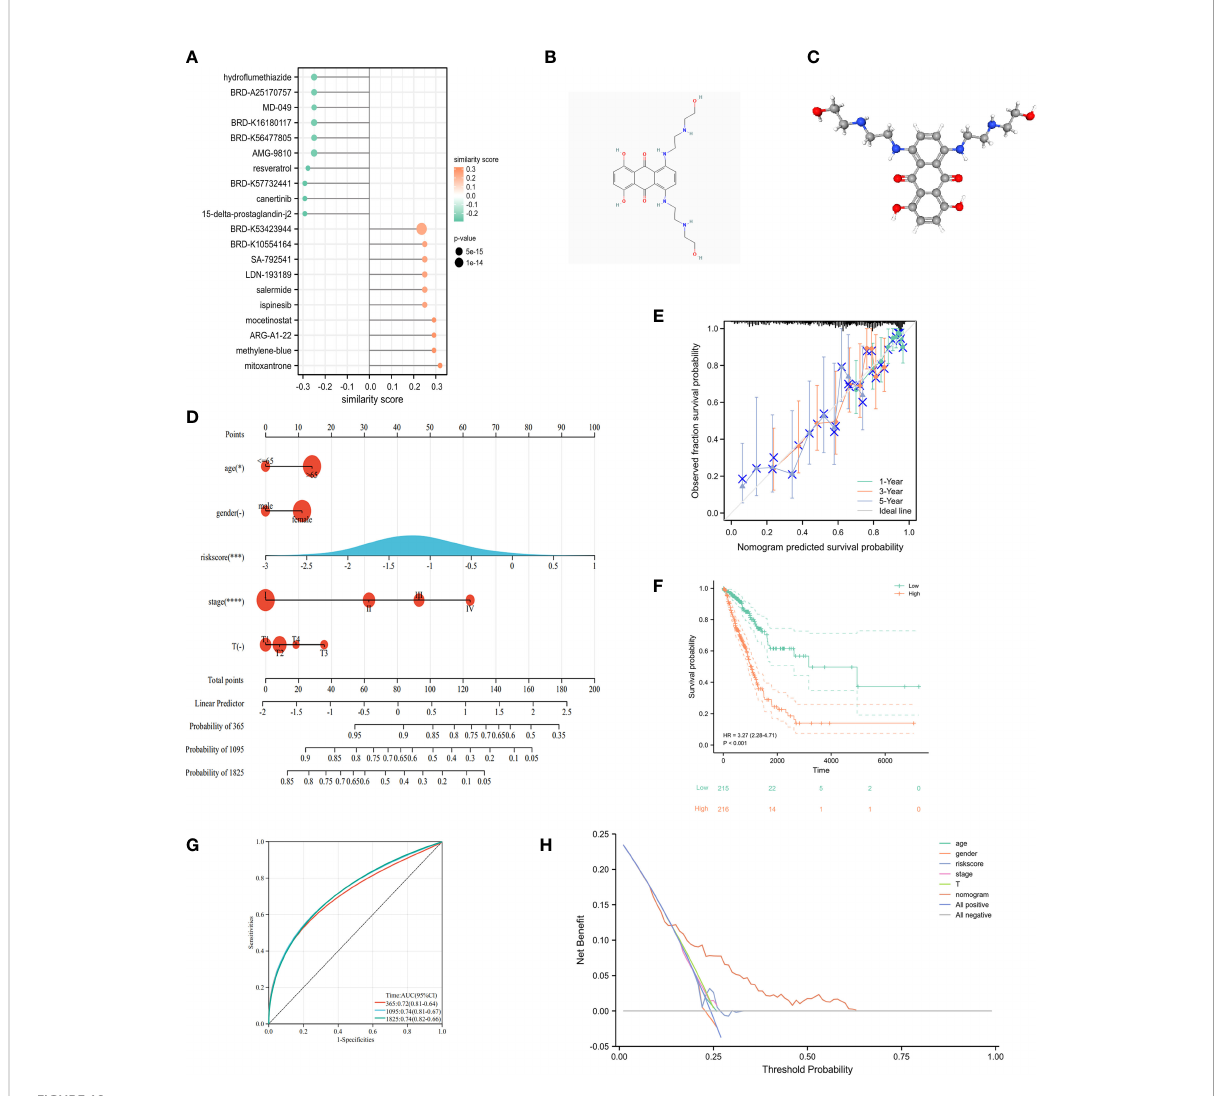
FIGURE 10 Clinical application of cuproptosis-related signature. (A) The potential drug for LUAD treatment. (B) The 2D structure of mitoxantrone. (C) The 3D structure of mitoxantrone. (D) The nomogram of the riskscore and clinical parameters (age, gender, T and pathological stage) of TCGA. (E) The calibration curves displayed the accuracy of the nomogram in the 1-, 3-, and 5-years. (F) Kaplan-Meier curve in multiple Cox regression analysis. (G) The time-ROC curve in multiple Cox regression analysis. (H) DCA curves to assess the ability of age, gender, risk score, T stage, and their combination to predict overall survival of LUAD patients in TCGA-LUAD cohort. * P <0.05, *** P <0.001, **** P